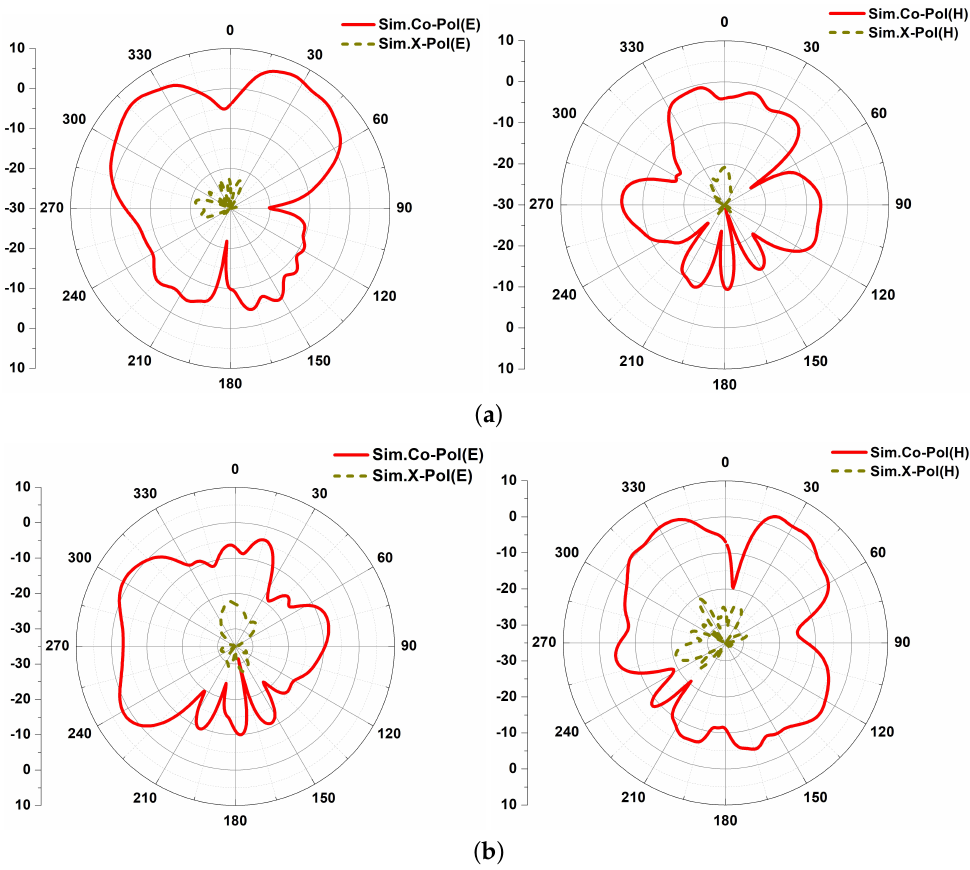
Figure 9. Radiation patterns for: ( a ) P1; and ( b ) P2.